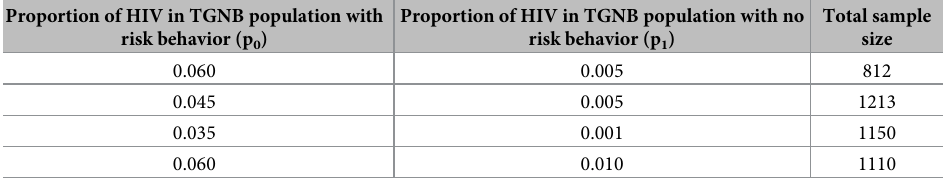
Table 1. The minimum sample size for comparing two proportions assuming a two-sided significance level of 95%, a power of 80% and a ratio of sample sizes of three. Proportion of HIV in TGNB population with risk behavior (p 0 )